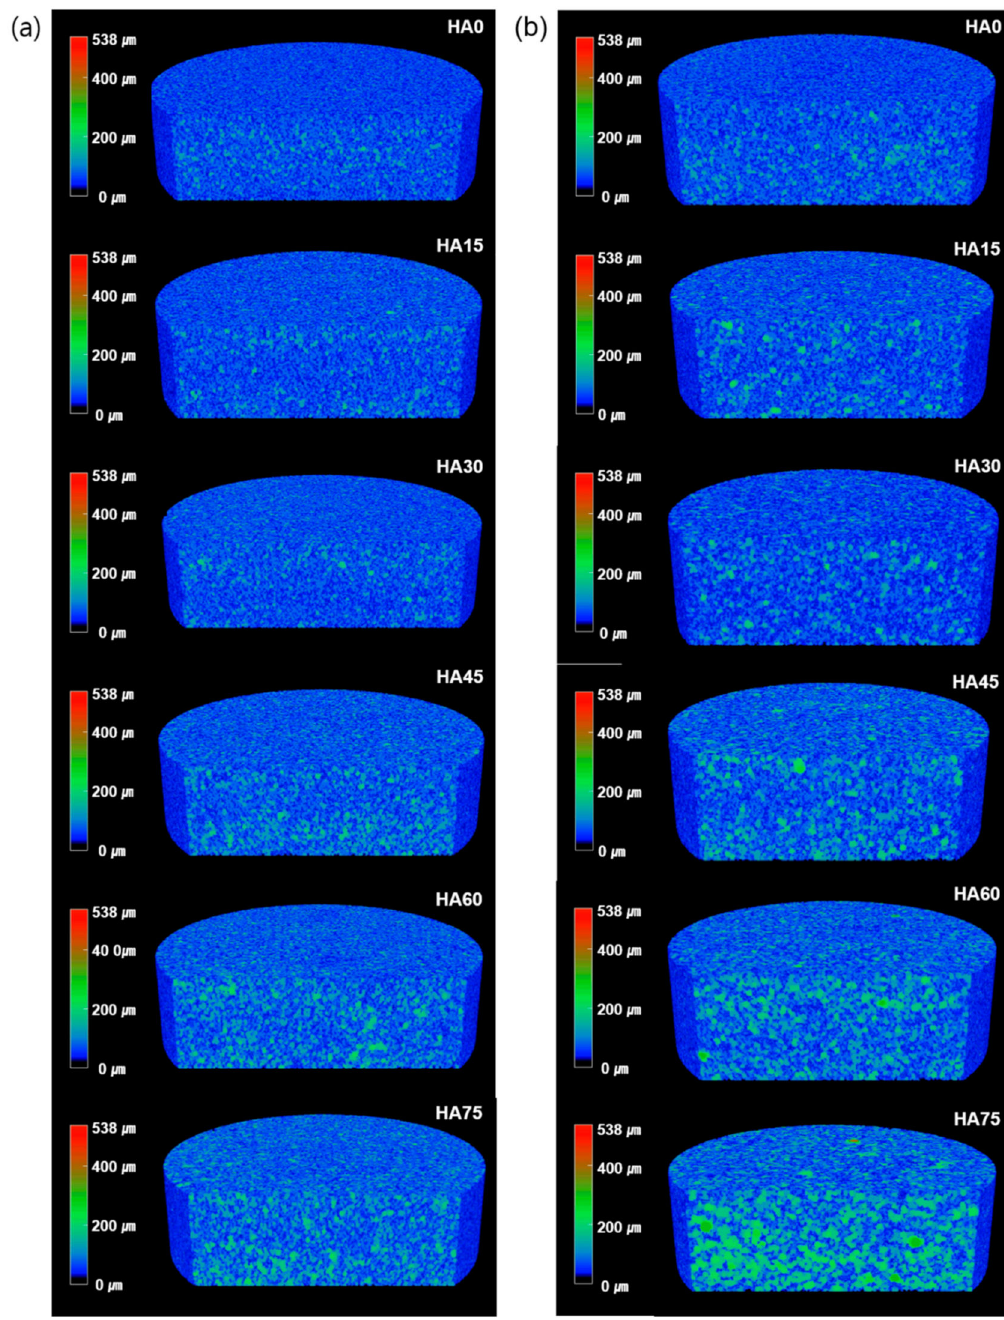
Figure 5. Microcomputed tomography morphologies of the 3D structure and the internal constitution of HA sca ff olds, ( a ) before sintering and ( b ) after